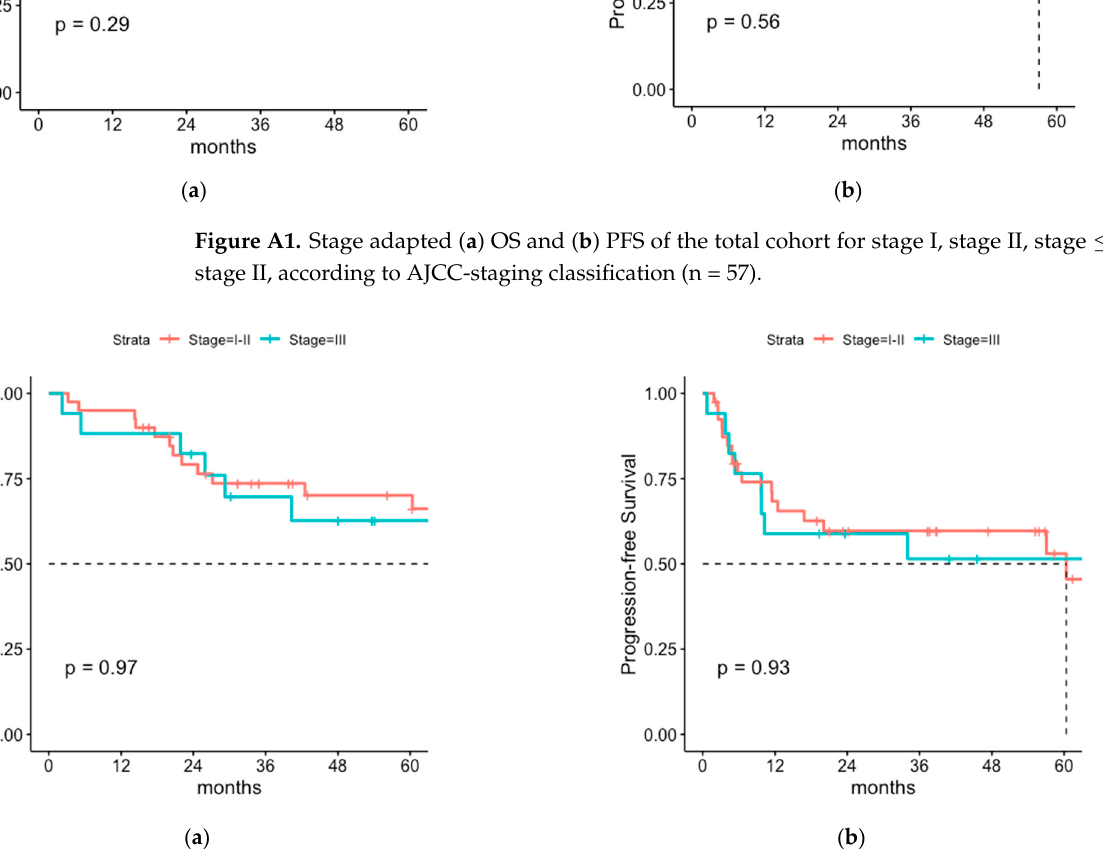
Figure A2. ( a ) Stage-adapted OS and ( b ) PFS of the total cohort for stage I-II and stage III, according to AJCC-staging classification (n = 57).